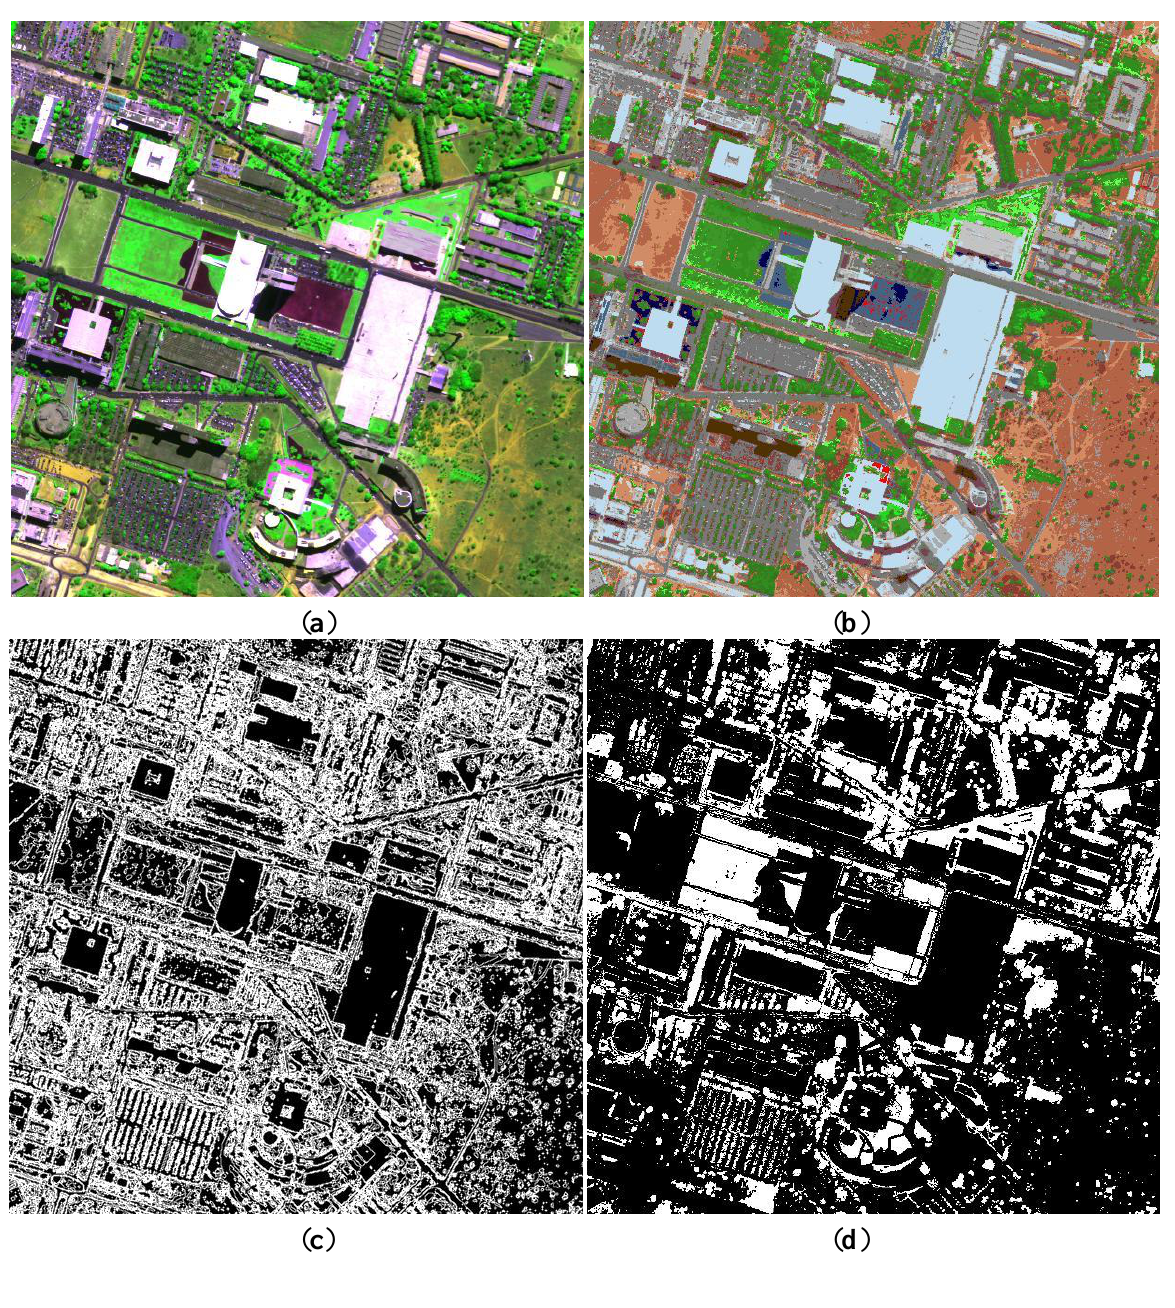
Figure 12. ( a ). Zoom of the WV-2 image, 2 m spatial resolution, acquisition date 2010-08- 04, radiometrically calibrated into TOARF values and shown in Figure 11(a), depicted in false colors (R: 5, G: 7, B: 2). ( b ) Zoom of the Q-SIAM™ preliminary map, shown in Figure 11(b), corresponding to the WV-2 sub-image shown in (a). Map legend: refer to Table 3. ( c ) Segment contours depicted as a 4-adjacency cross-aura measure generated from the Q-SIAM™ preliminary map shown in (b). Cross-aura values range in {0, 4}. ( d ). Binary vegetation mask generated from the Q-SIAM™ preliminary map shown in Figure (b). This is an example of semantic stratum equivalent to a symbolic multi-part polygon defined accordingly to the OGC